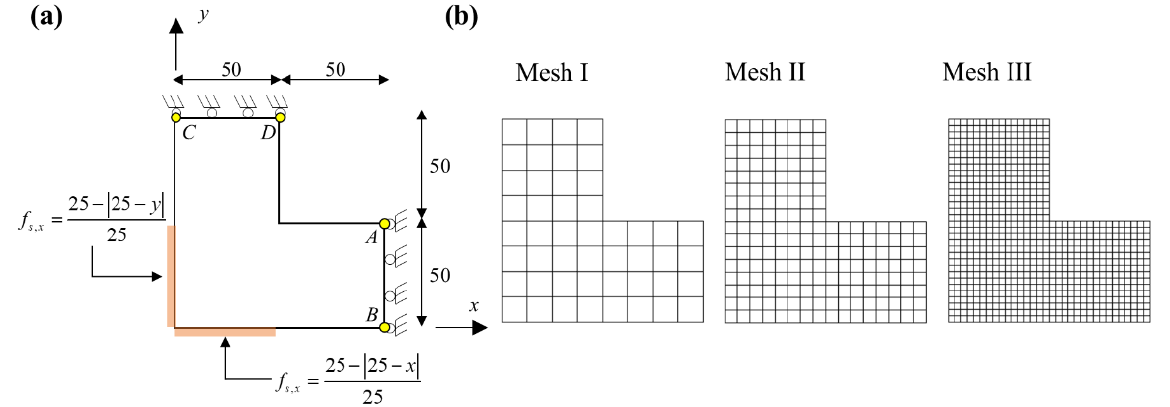
Figure 13. Automotive wheel problem: ( a ) Problem description. ( b ) Sequence of meshes (Mesh I, II, and III) used.